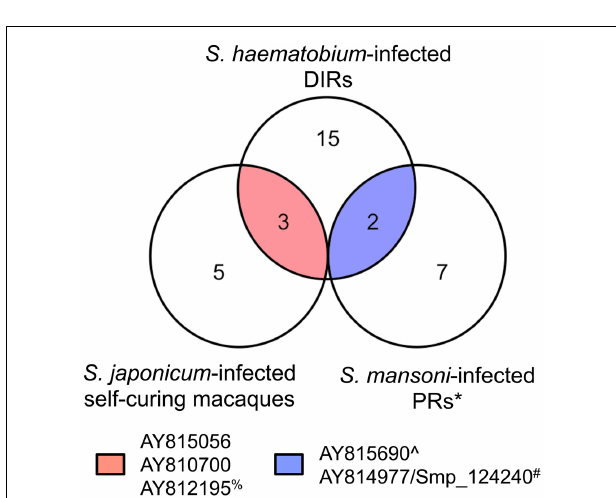
FIGURE 7 | Different disease models of schistosomiasis resistance show common IgG responses to some arrayed antigens . Venn diagram depicting common IgG reactive proteins between Schistosoma haematobium -infected humans from an endemic area in Africa who acquire drug-induced resistance (DIR) after praziquantel treatment, Schistosoma japonicum -infected self-curing rhesus macaques, and Schistosoma mansoni -infected humans from an endemic area of Brazil who are naturally resistant (PRs). *Data from Gaze et al. (20); % IgG1 response to AY812195 is significantly different between DIRs before and after praziquantel treatment but not between DIRs and CIs post-treatment; # AY814977 and Smp_124240 are the respective S. japonicum and S. mansoni orthologs of SNaK1 β . ^ We believe the sequence represented by AY815690 [“myosin-7” ( S. japonicum )] has been incorrectly annotated due to its high degree of homology with other parasite orthologs of ribosome-binding protein 1 and lack of BlastP hits with any form of